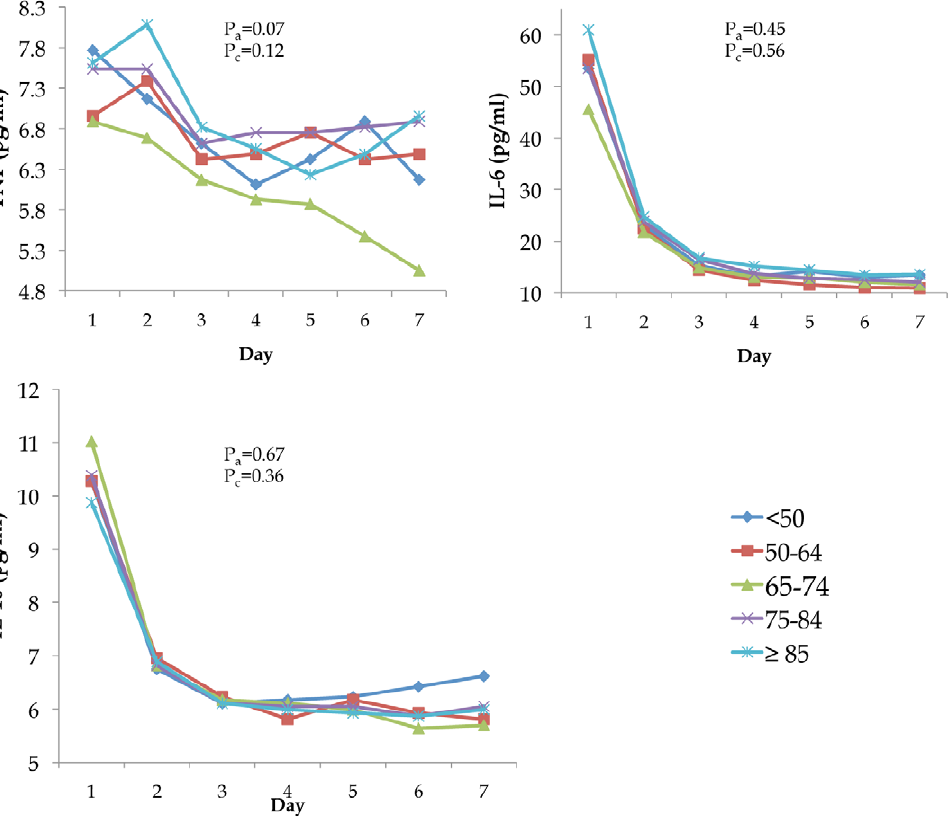
Figure 2. No differences were found in the mean values of inflammatory (TNF, IL-6, and IL-10) markers when stratified by age group. Markers were measured upon presentation to the ED and over the first week of hospitalization. Pa are p values from Tobit models adjusted for sex, race, comorbidity, and smoking status to compare differences in mean levels of markers on Day 1 across different age groups. Pc are p values from mixed effects model adjusted for sex, race, comorbidity, and smoking status to compare mean levels over the first week.